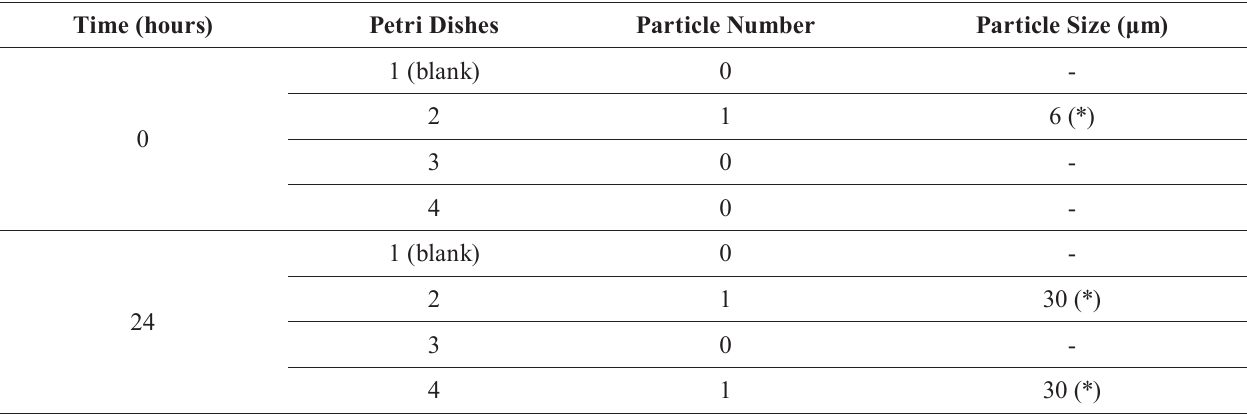
TABLE V - R esults obtained from microscopic particle testing Time (hours)